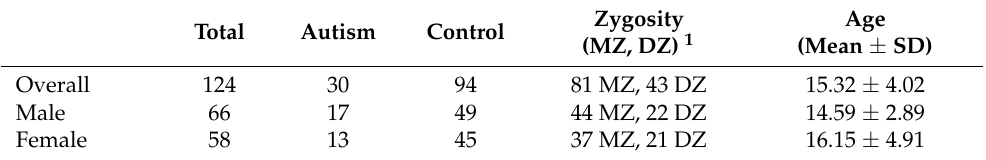
Table 1. Participant demographics. 1 MZ and DZ refer to monozygotic and dizygotic twins.